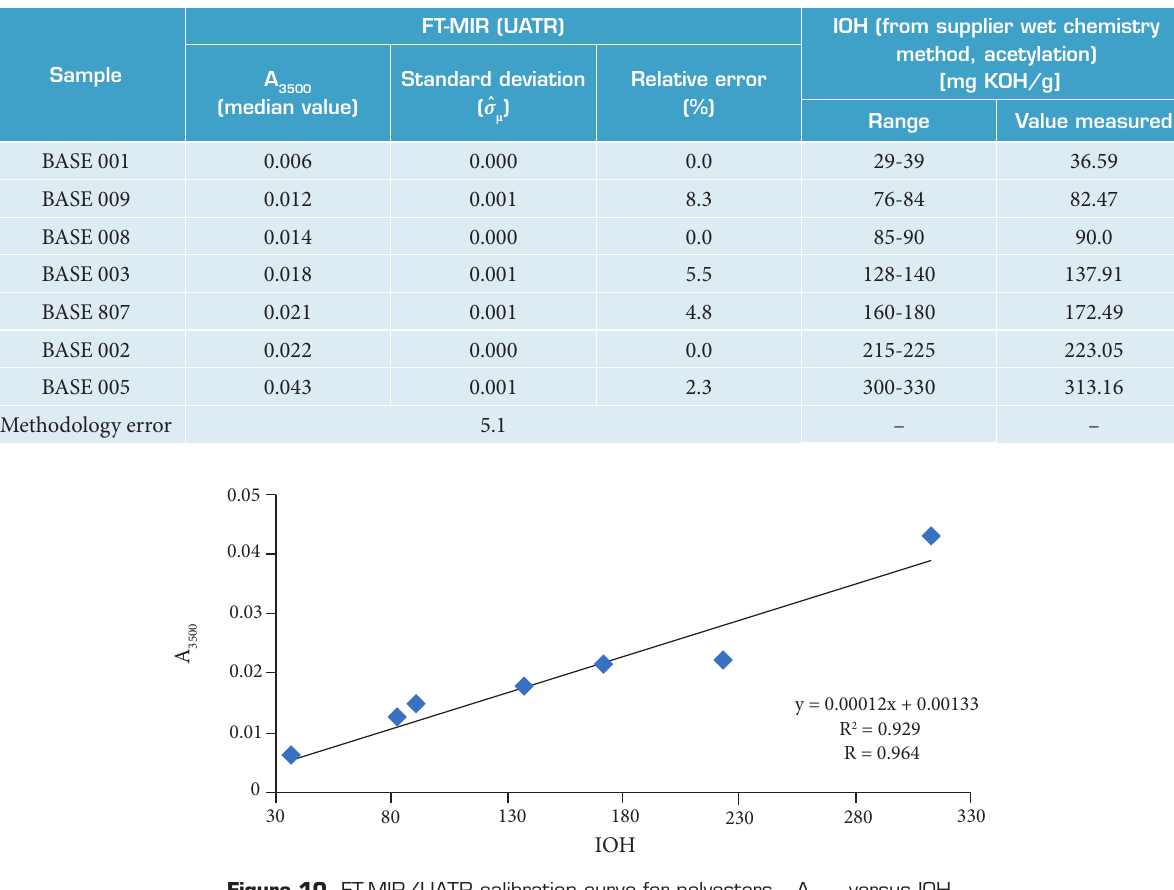
Table 5. Methodologies data and FT-MIR (UATR) for IOH determination in polyesters.